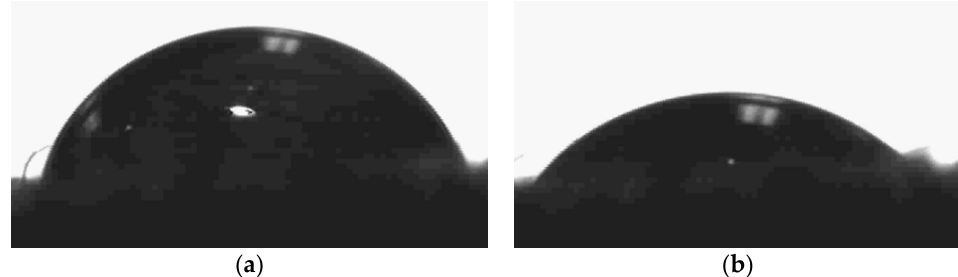
Figure 4. Water droplets on the surface of ( a ) untreated fabric, and ( b ) treated fabric after 3 s of contact.